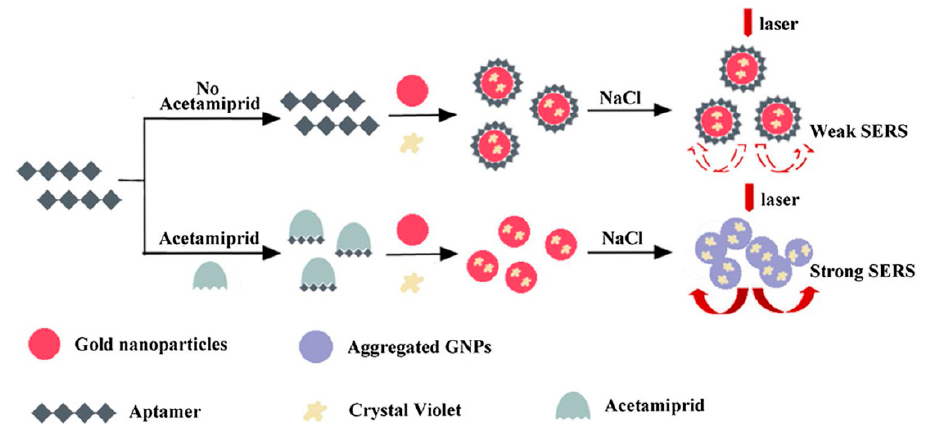
Figure 11. Schematic representation of the SERS-based biosensor for the detection of acetamiprid (AC). (Reprinted with permission from Springer, 2018 [76]).